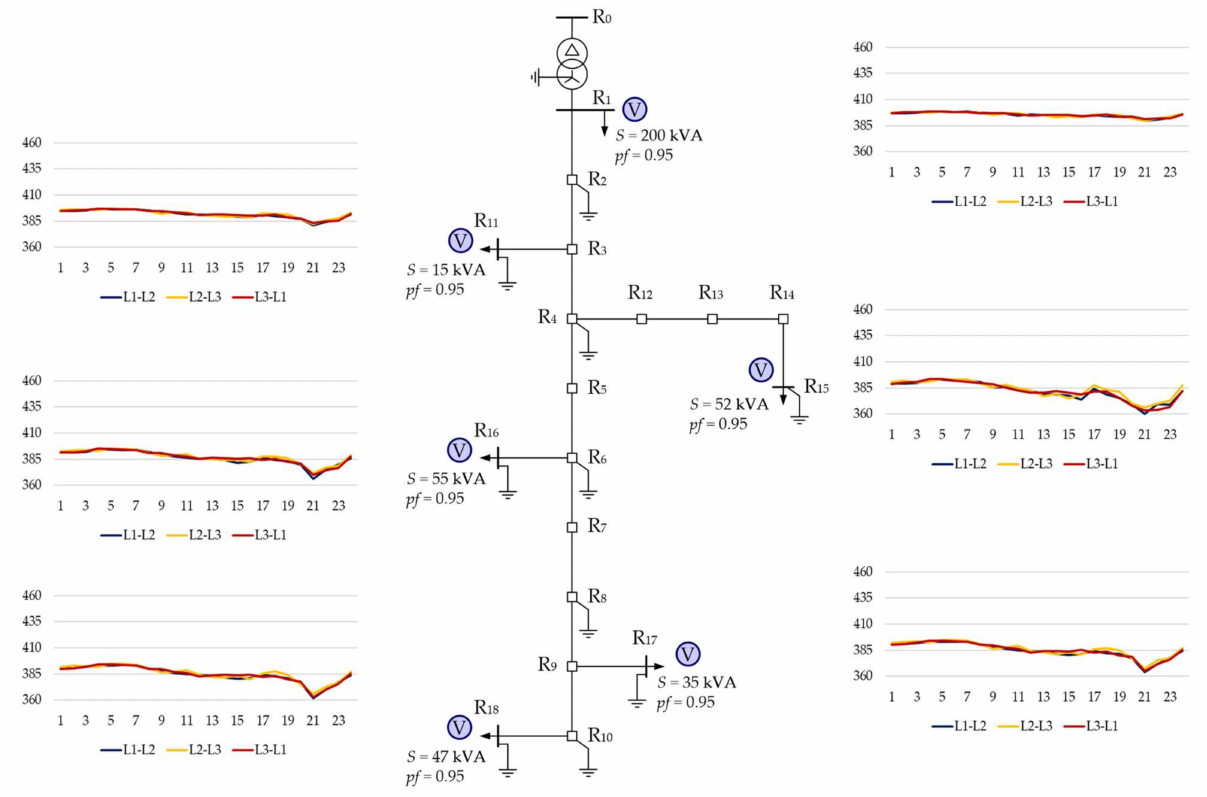
Figure A5. Daily simulation results for variant V6: phase-to-phase voltages (V).